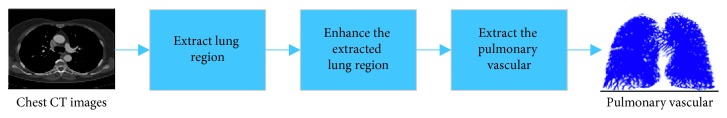
The flowchart of this method.